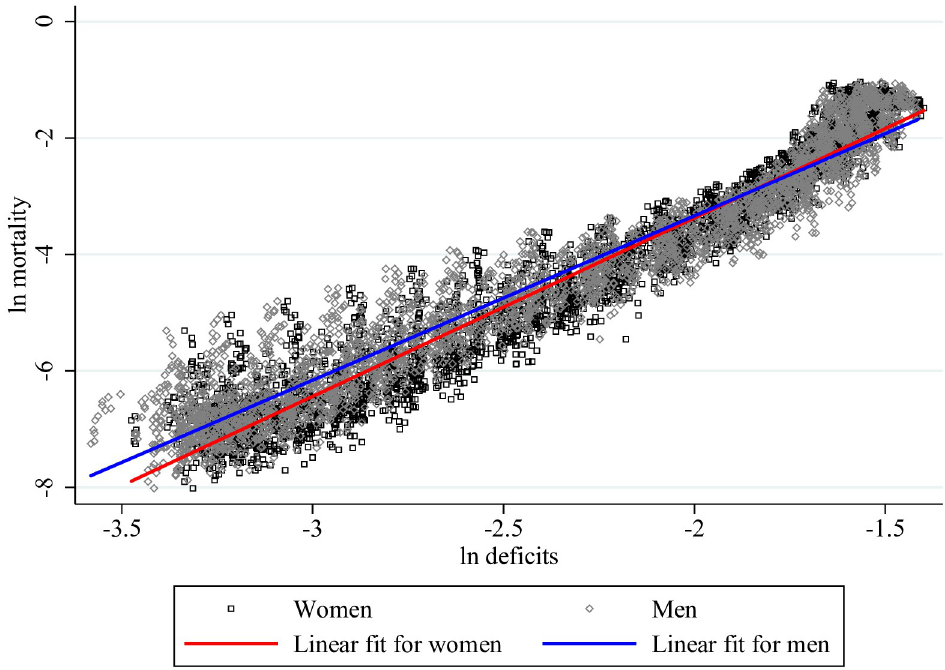
Fig 2. Frailty and mortality of women and men. Notes: This figure plots mortality-deficits observations (both logged) by gender for selected group of countries where age-specific mortality rates are available at the Human Mortality Database. The fitted lines are simple OLS regression